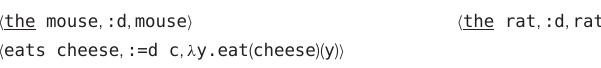
TABLE 6 | Learned minimalist lexicon X 1 at time t = 1. h the mouse eats cheese , :c , eat ( cheese )( mouse ) i